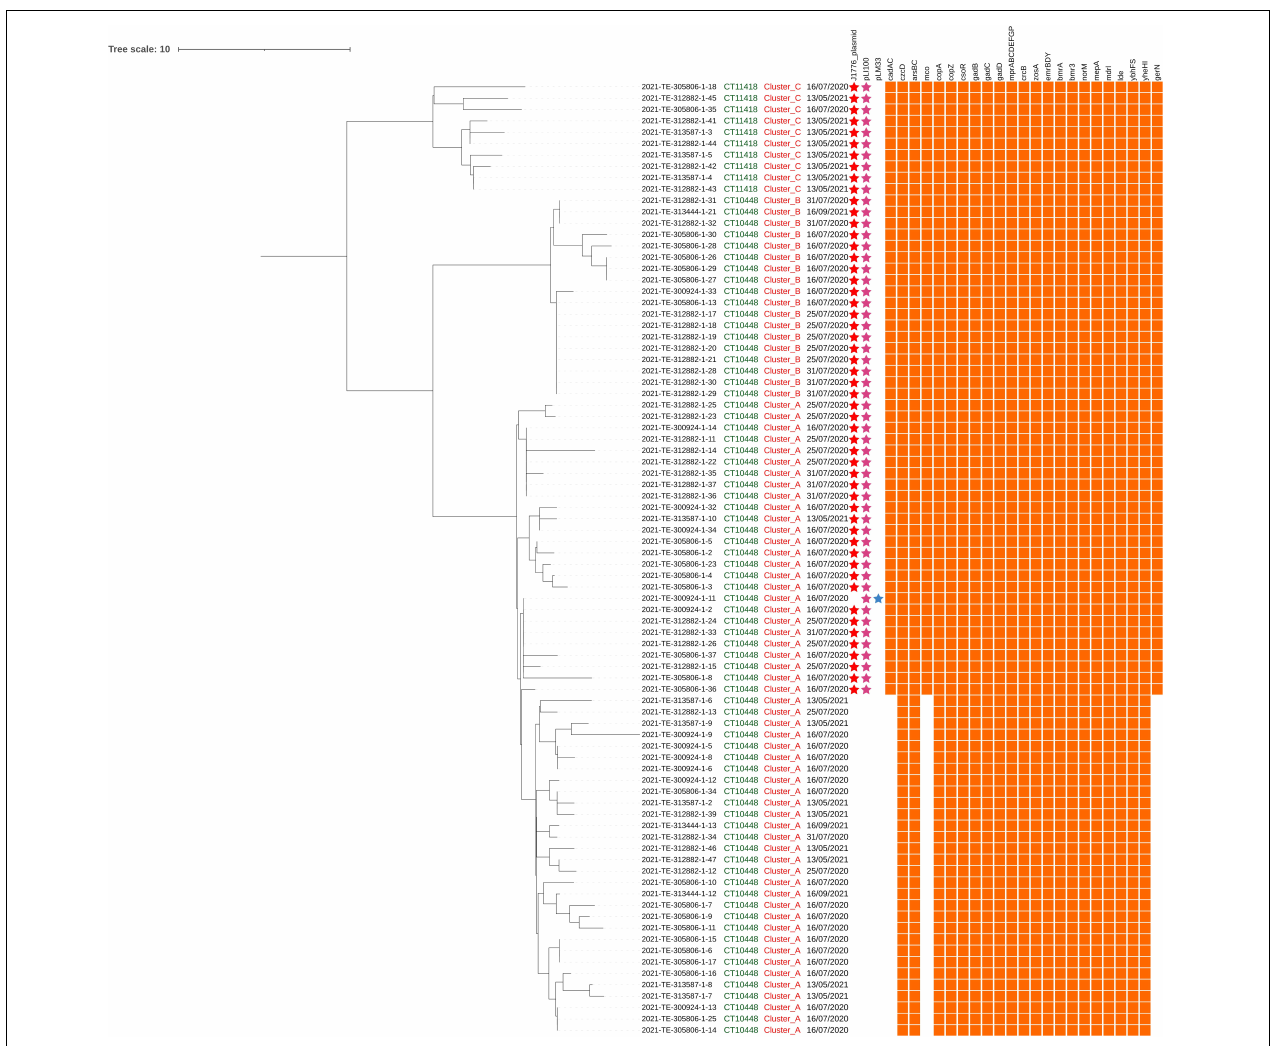
FIGURE 2 | Single-nucleotide polymorphisms (SNPs) analysis of Lm strains belonging to ST2801. The first, the second, and the third columns indicate the CT, the cluster, and the sampling date, respectively. The presence/absence matrix represents, from left to right, plasmids (j1776 plasmid, pLI100, and pLM33) and genes involved in stresses